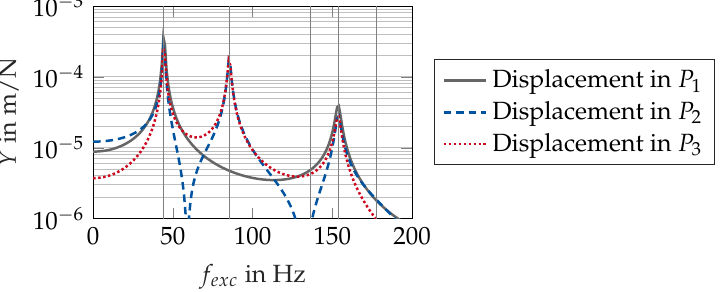
Figure 5. Magnitudes ˆ Y of the transfer mobility for force application in P 2 as a function of the excitation frequency f exc